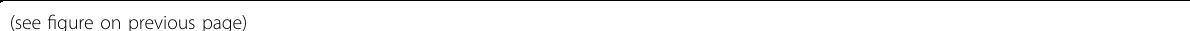
Fig. 2 Binding and neutralization of the Omicron variant by bispeci fi c antibodies. a Schematic diagrams showing the structures of bispeci fi c antibodies. b SDS-PAGE and cross-linking SDS-PAGE gels showing the sizes of the representative bispeci fi c antibodies and their parental antibodies. c Binding speci fi cities of the bispeci fi c antibodies to the SARS-CoV-2 RBD-His, Omicron trimer-His, or RBD-His protein. d Binding af fi nities of the bispeci fi c antibodies to the SARS-CoV-2 RBD-His, Omicron trimer-His, or RBD-His protein were measured by BLI experiments. ND represents not determined. e Neutralization by bispeci fi c antibodies against the SARS-CoV-2 VOCs, including Omicron, BA.2, and sarbecoviruses. f Neutralization of bispeci fi c antibodies against authentic BA.1.1